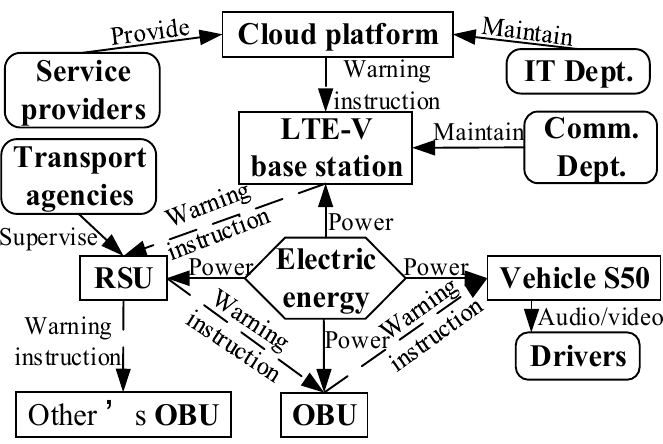
Figure 14. Function model of vehicle collision-warning service system. Then, Collision warning between vehicles and pedestrians. As shown in Figure 15, a warning service instruction is sent to pedestrian 1; the vehicle can automatically sound its horn. In addition, if pedestrian 1 fails to respond to the signal, the cloud platform warns pedestrian 1 by making the mobile terminal of the nearest pedestrian 2 also emit a